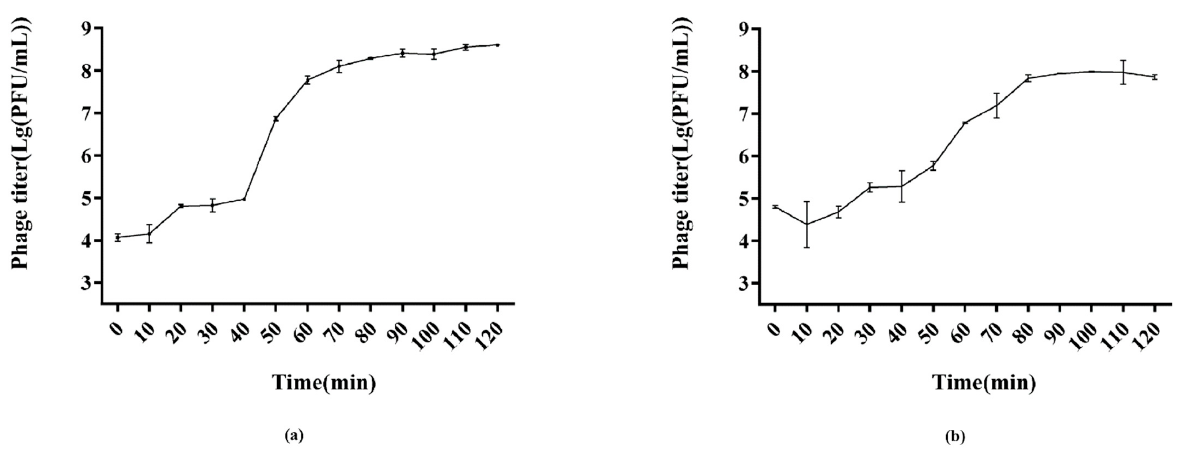
Figure 3. One step growth curves of phages. ( a ) phage PSE-D1. ( b ) phage PST-H1.